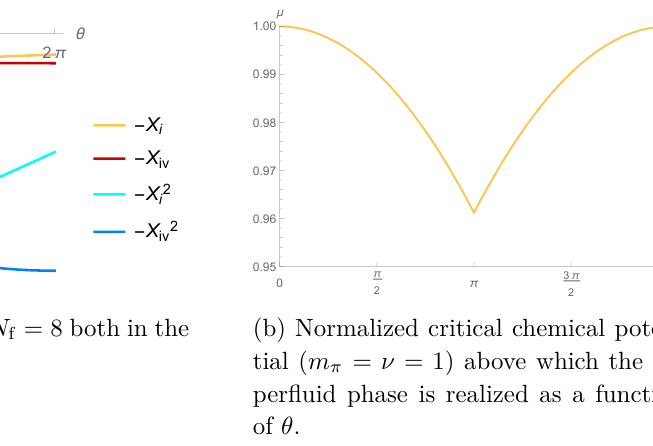
(a) The CP order parameter (cid:10) F ˜ F (cid:11) as a func- tion of θ in the normal phase. Figure 9 . θ -dependence of the CP order parameter for N f = 7 .